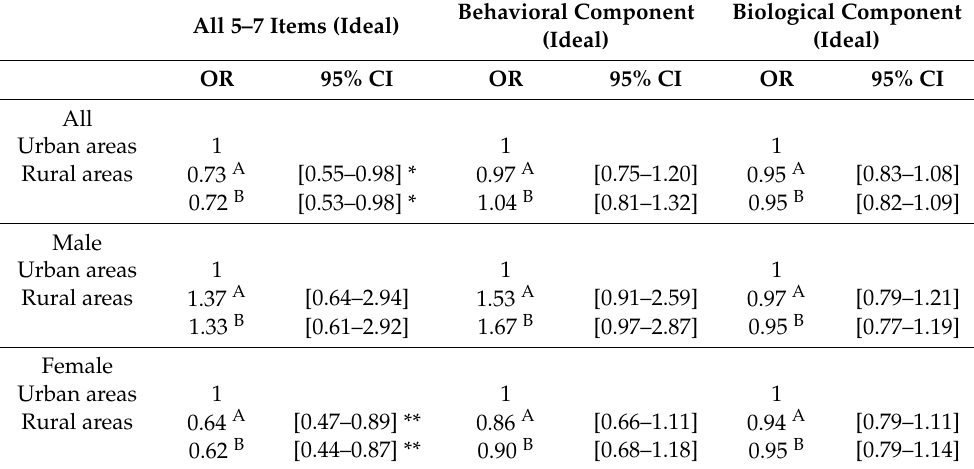
Table 4. The relation between the place of residence and the ideal global ICH, behavioral, and biological components, and according to